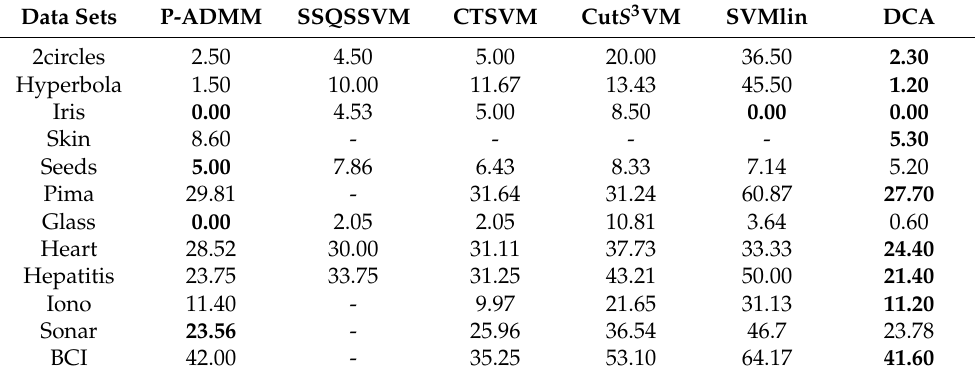
Table 2. Misclassification rates (%) for datasets.